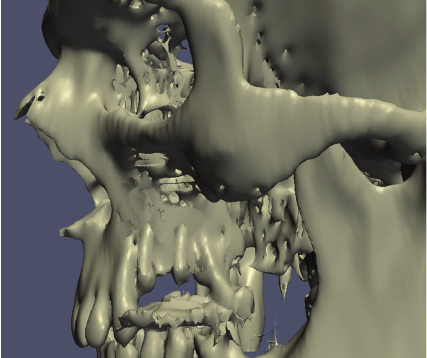
Figure 4: CT scan view after implant